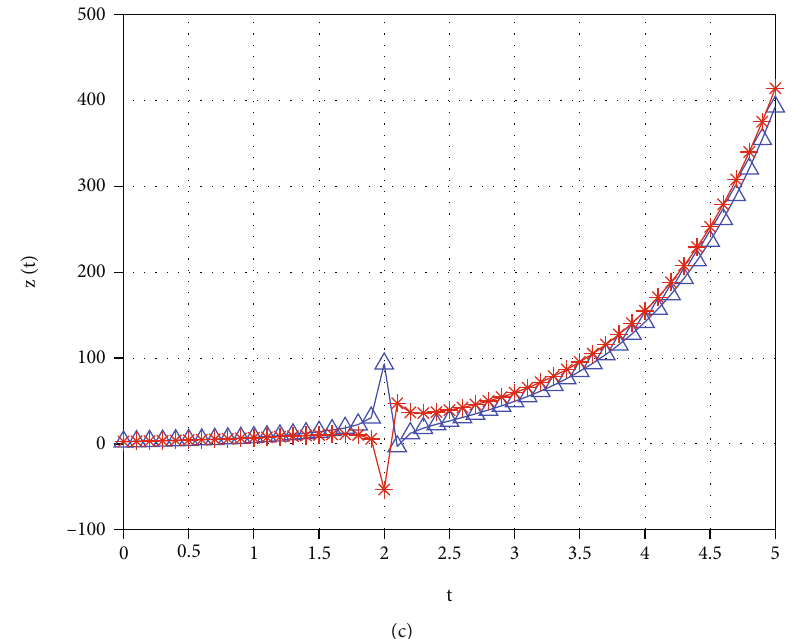
Figure 6: (a) Function j p ð t Þj for t ∈ ½ 0, 1 (cid:2) . (b) Function z ð t Þ for t ∈ ½ 0, 1 (cid:2) . (c) Function z ð t Þ for t ∈ ½ 0, 5 (cid:2) .